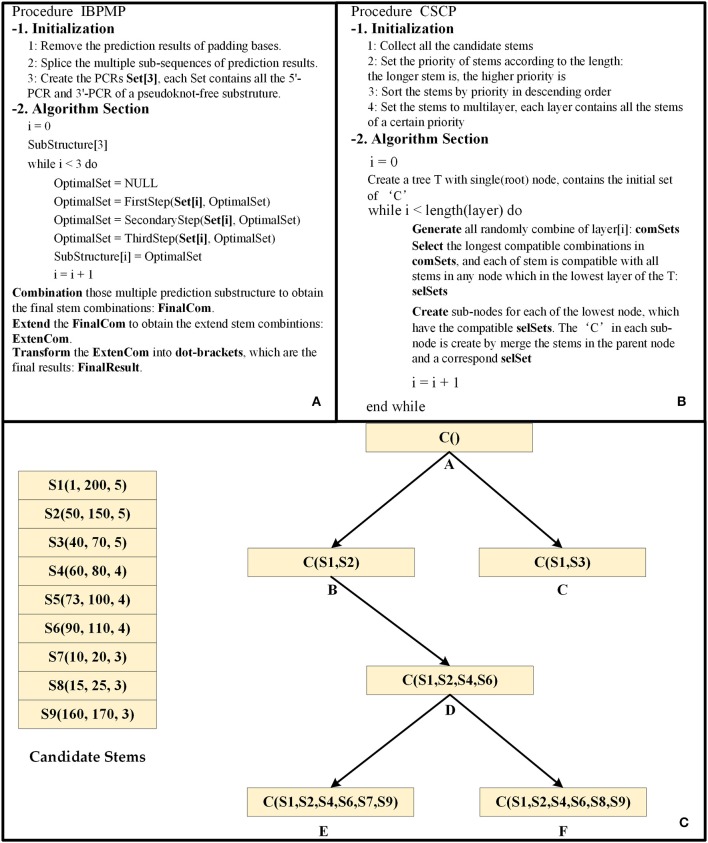
The principle diagram of IBPMP. (A) is the procedure of IBPMP, which contains two parts: initialization and algorithm section. In the initialization, the procedure processes the prediction results of PU as the input of CU. In the algorithm section, it obtains the prediction secondary with pseudoknots. See below for details of FirstStep, SecondaryStep, and ThirdStep. (B) The procedure of CSCP, which contains two parts: initialization and algorithm section. In the initialization, it collects all stems and set priority for them. In the algorithm section, it obtains the optimal stem combinations. (C) is an example of the CSCP.